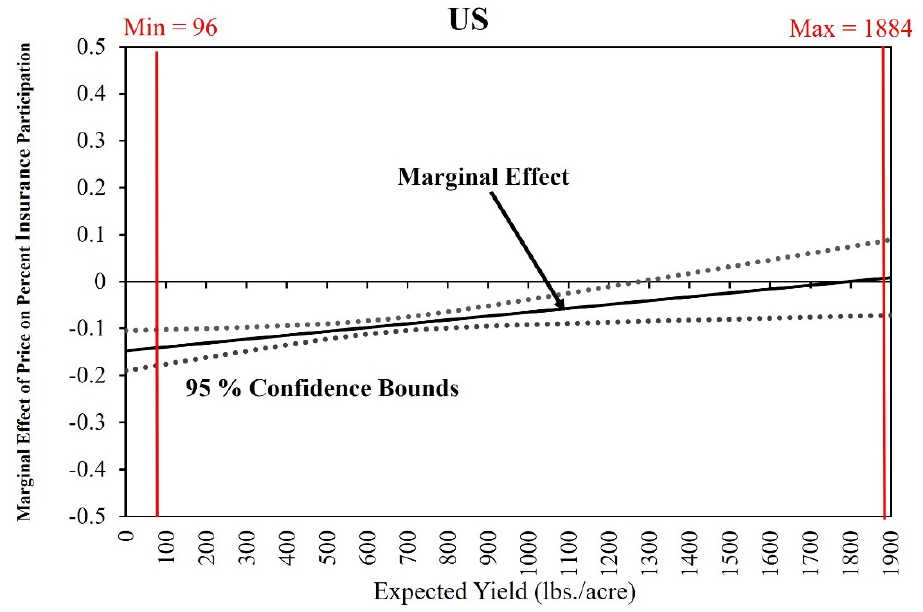
Figure 4. Marginal effect of expected price on insurance participation given expected yield for US.